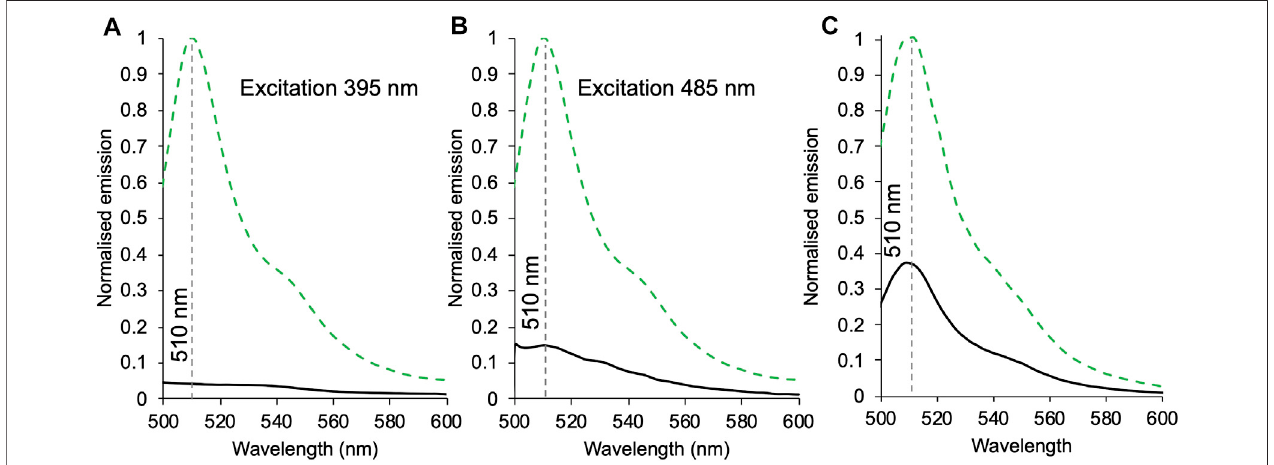
FIGURE 3 | The effect of heterodimerisation on fl uorescence emission. Emission of 1 μ M of sfGFP 148SCO (green dashed) or GFP b 148-71 (black) excited at either 395 nm (A) or485 nm (B) . (C) Emissionof1 μ MsfGFP 204SCO (green dashed) and GFP b 204-71 (black) onexcitation at485 nm.Spectrawerenormalised tosfGFP 148SCO (A, B) or sfGFP 204SCO (C)